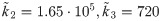
Influcence of noise on the maxima of the stationary solution.Influence of noise on the maxima of the stationary solution, showing that noise shifts the maxima to the extent that bifurcations can be destroyed or induced. The red line shows the deterministic fixed points, the first black line shows the solution for a burst size 1 (the standard Schlögl model). With each further black line, the burst size r increases by 10. Starting from the first black curve next to the red one, the parameter value r of the black curves are therefore: 1,11,21,31,41. The other parameters are (a) k˜2=1.65·105,k˜3=720, (b) k˜1=5.33·106,k˜3=800, (c) k˜1=8·106,k˜2=1·105.